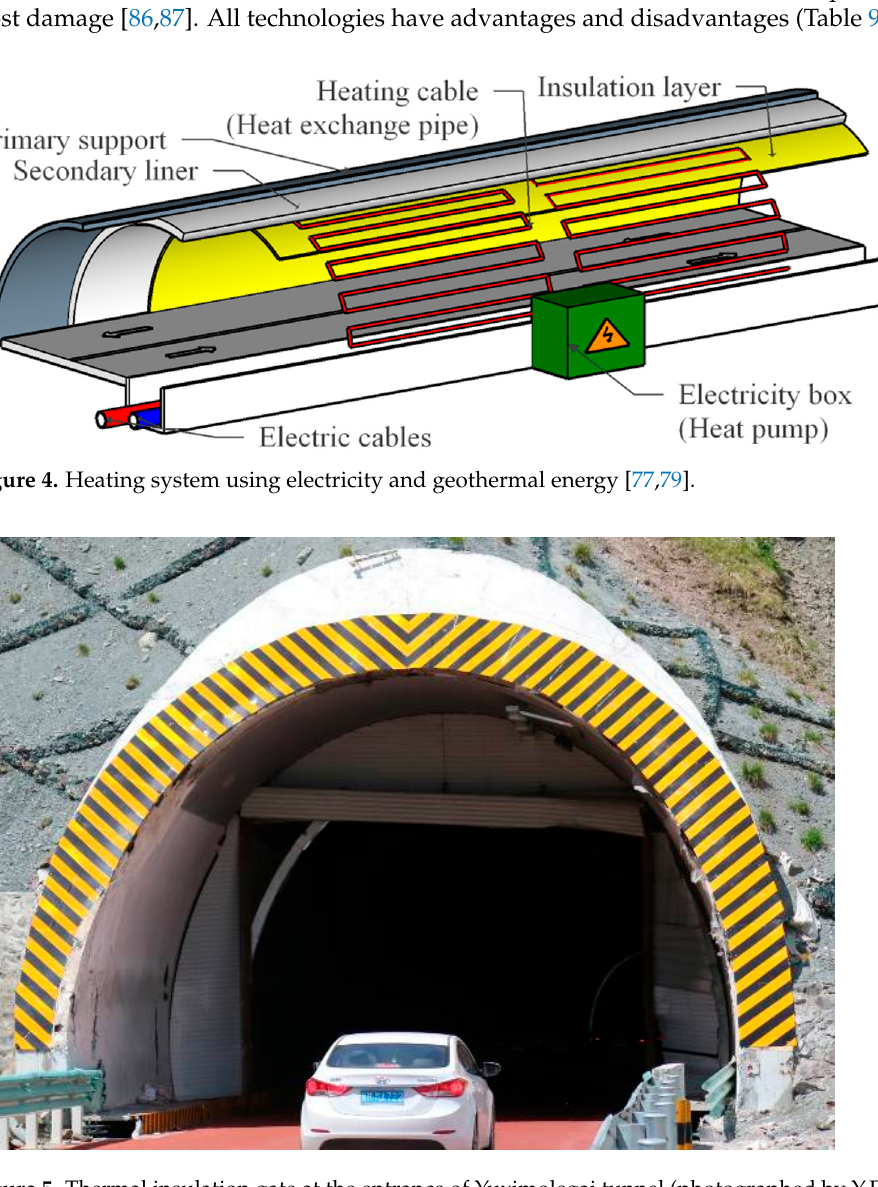
Figure 6. Snow shelter at the entrance of a tunnel (photographed by Y.F. Zhou).